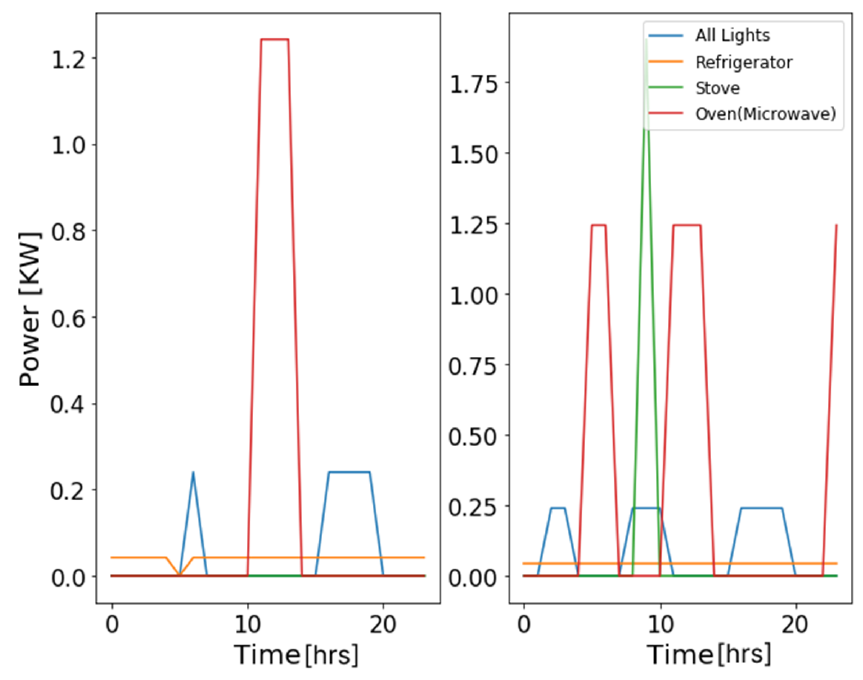
Figure 5. Power usage by each device with the proposed SV load allocations vs. real usage according with the REDD [31] database.